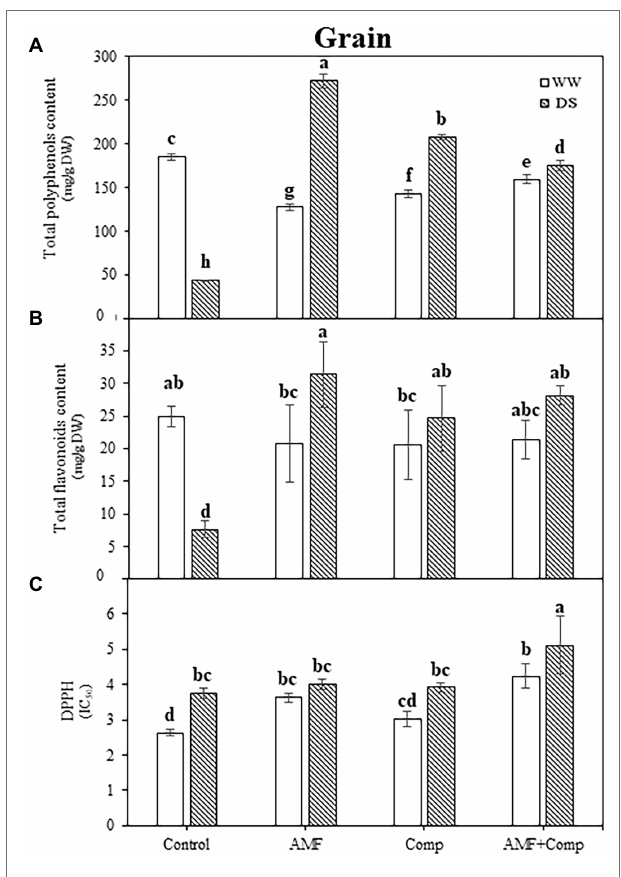
FIGURE 5 | Effects of water regimes (WW; well-watered or DS: drought stress) on seed antioxidant properties (A) total phenolics, (B) total flavonoids, and (C) DPPH (2,2-diphenyl-1-picrylhydrazyl) of non-amended and non- inoculated quinoa (control), and quinoa inoculated with arbuscular mycorrhizal fungi (AMF) and/or amended with compost (Comp). Data are mean ± SD. Means followed by the same letters are not significantly different at p <